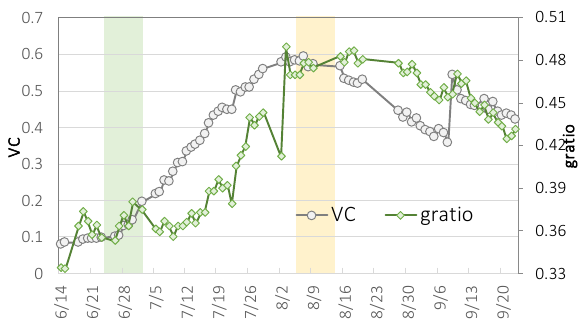
Figure 4. Daily changes of gratio and VC (light green: maximum tiller stage and light orange: heading date)